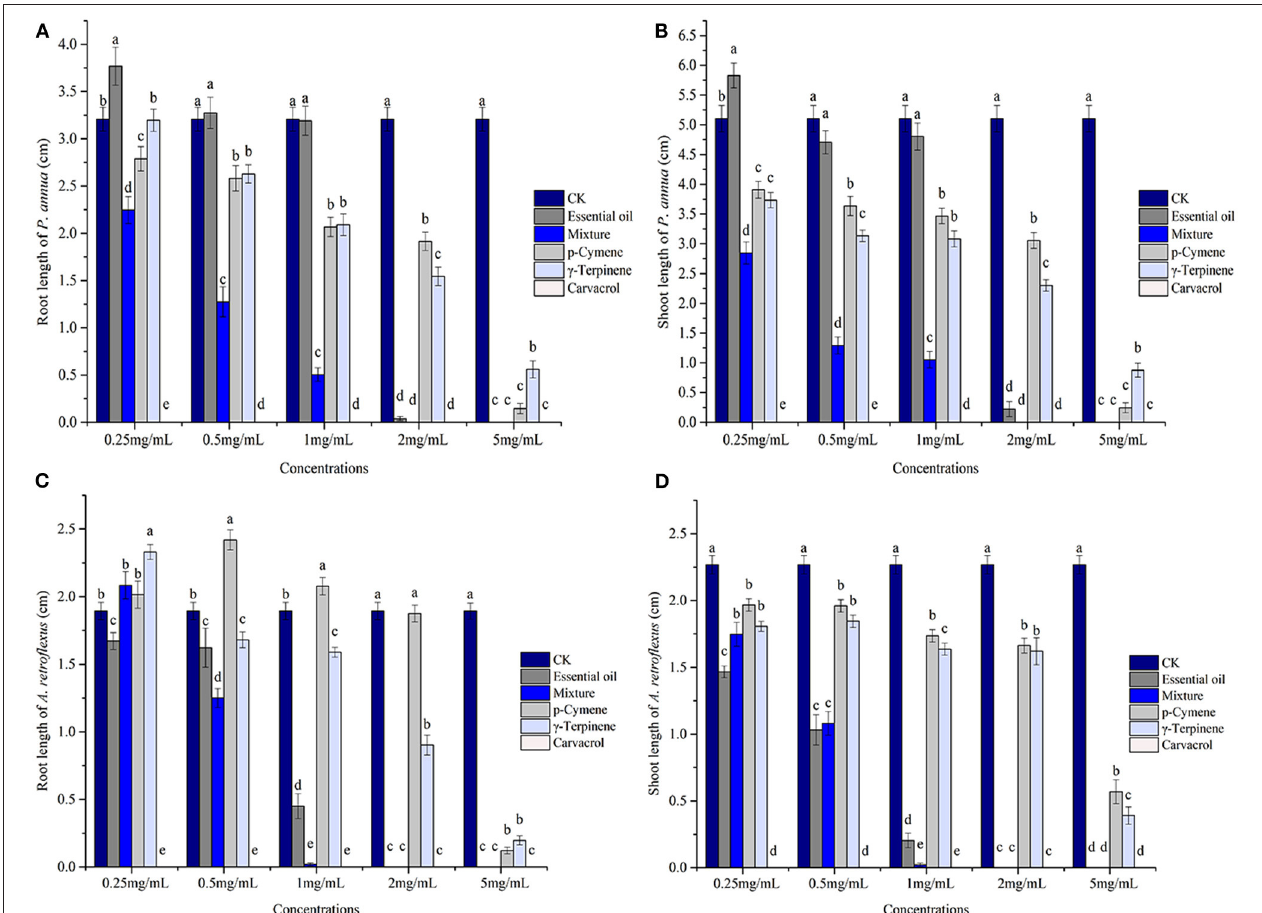
FIGURE 2 | Phytotoxic effects of Thymus proximus essential oil (EO) and its major constituents, p-cymene, γ -terpinene, carvacrol, and their mixture on the seedling growth of Poa annua and Amaranthus retroflexus ( n = 50). Different letters represent a significant difference at p < 0.05 level according to the Fisher’s LSD test. (A) root length of P. annua ; (B) shoot length of P. annua ; (C) root length of A. retroflexus ; and (D) shoot length of A. retroflexus